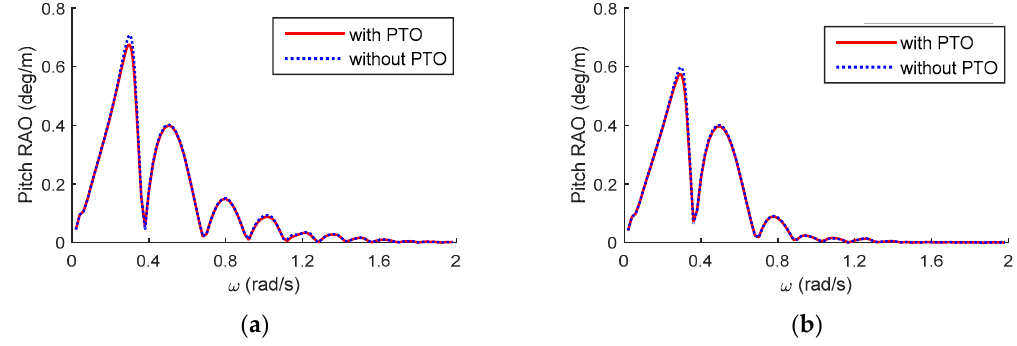
Figure 10. Platform pitch RAOs: ( a ) Wave-heading angle is 0.0 deg; ( b ) Wave-heading angle is 22.5 deg.